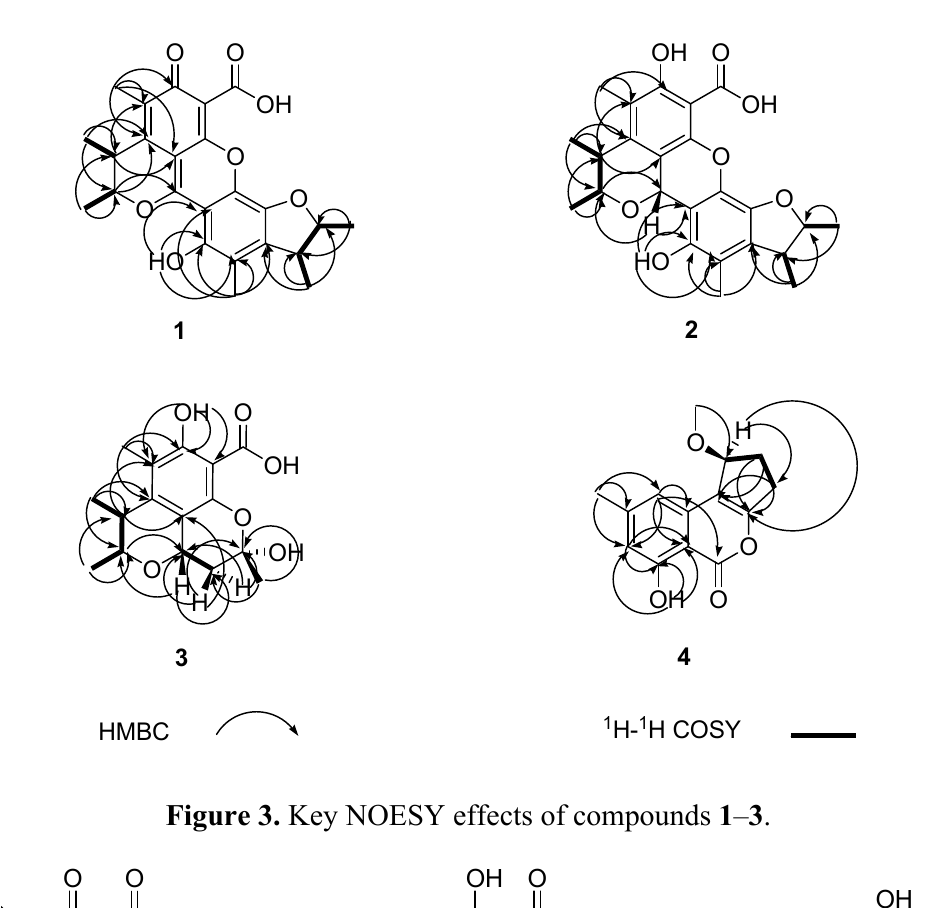
Figure 2. 1 H- 1 H COSY and key HMBC correlations of compounds 1 – 4 .